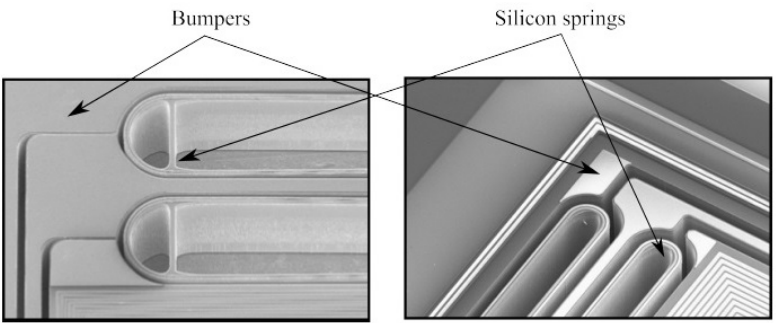
Figure 15. Hard shock stops located beyond the springs ends in the